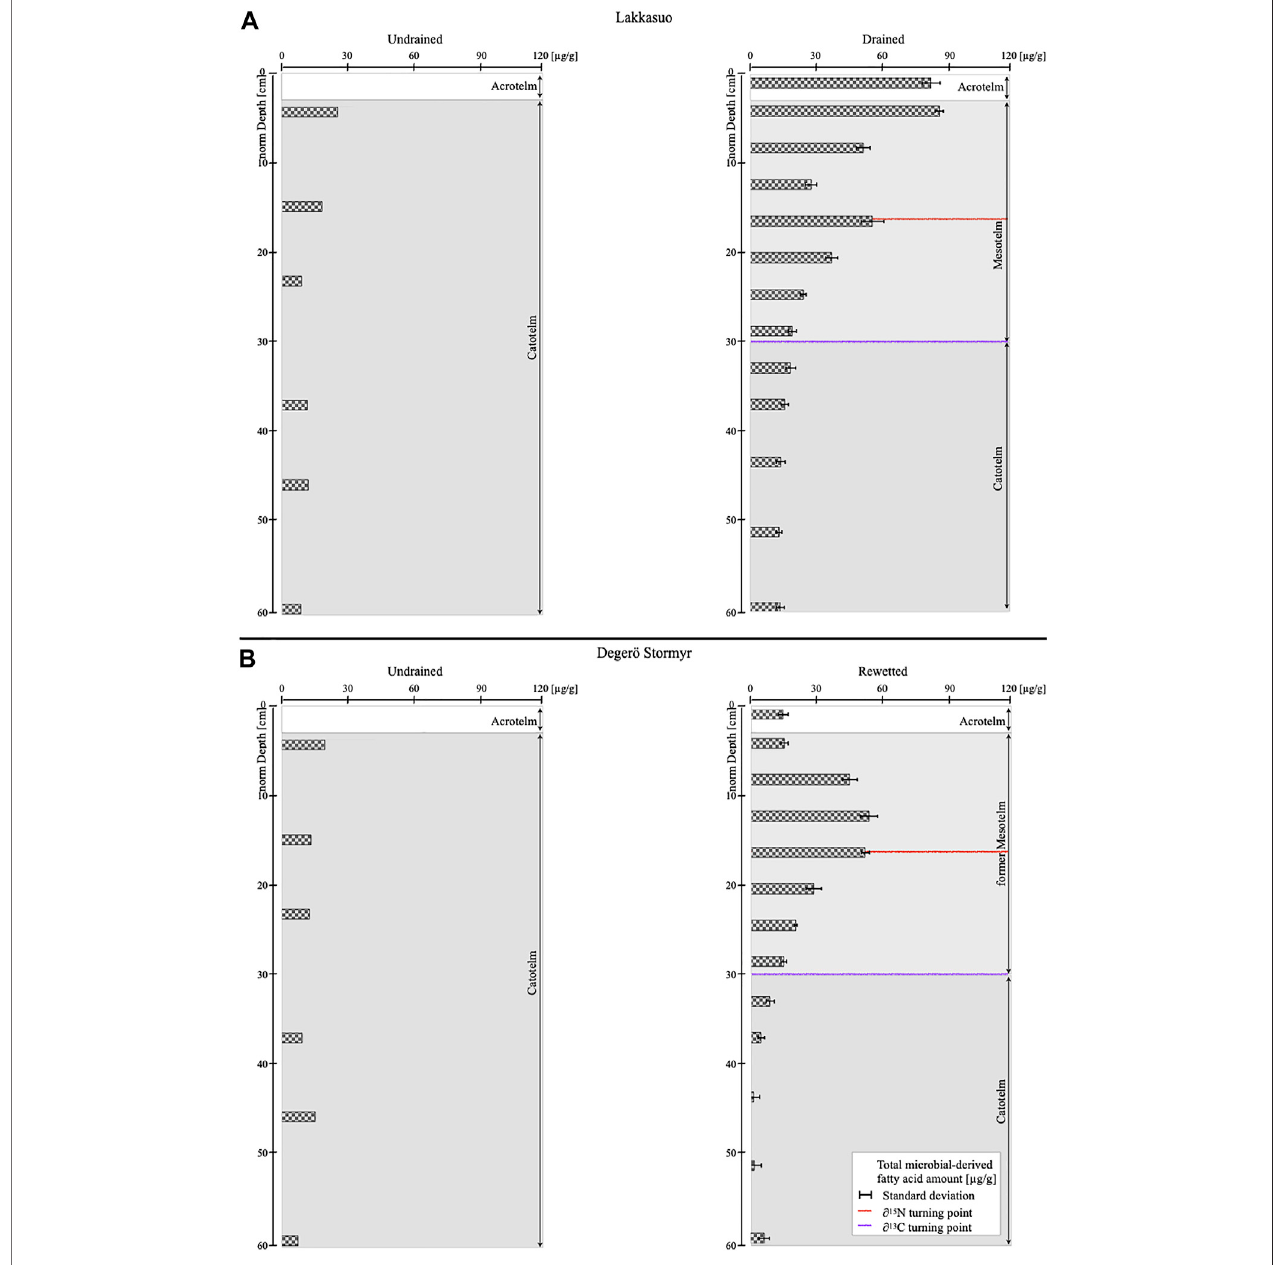
FIGURE1| Averagevaluesoftotalmicrobial-derivedmembranefattyacidconcentrations[µg/g] (A) Lakkasuo:undrained(LU 1-3 )anddrained(LD13 1-3 ) (B) Degerö Stormyr: undrained (DU 1-3 ) and rewetted (DR13 1-3 ); Red reference line gives the δ 15 N turning point, violet reference line gives the δ 13 C turning point.